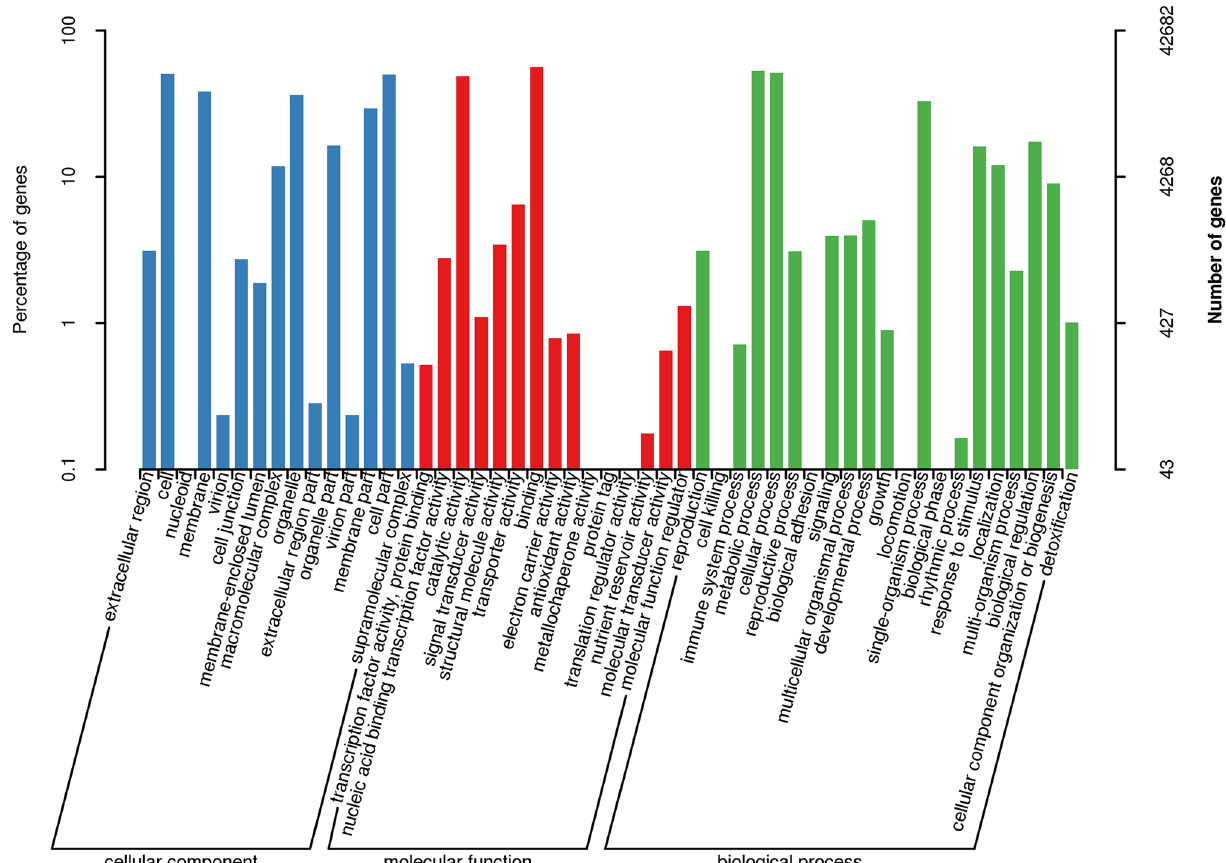
Figure 2. Gene Ontology (GO) classification of unigenes. All the annotated unigenes were divided into three functional GO categories: cellular component (CC), molecular function (MF), and biological process (BP). The x-axis represents the enriched GO terms. Left y-axis shows the percentage of unigenes in subcategories of each main category. Right y-axis indicates the number of unigenes in each